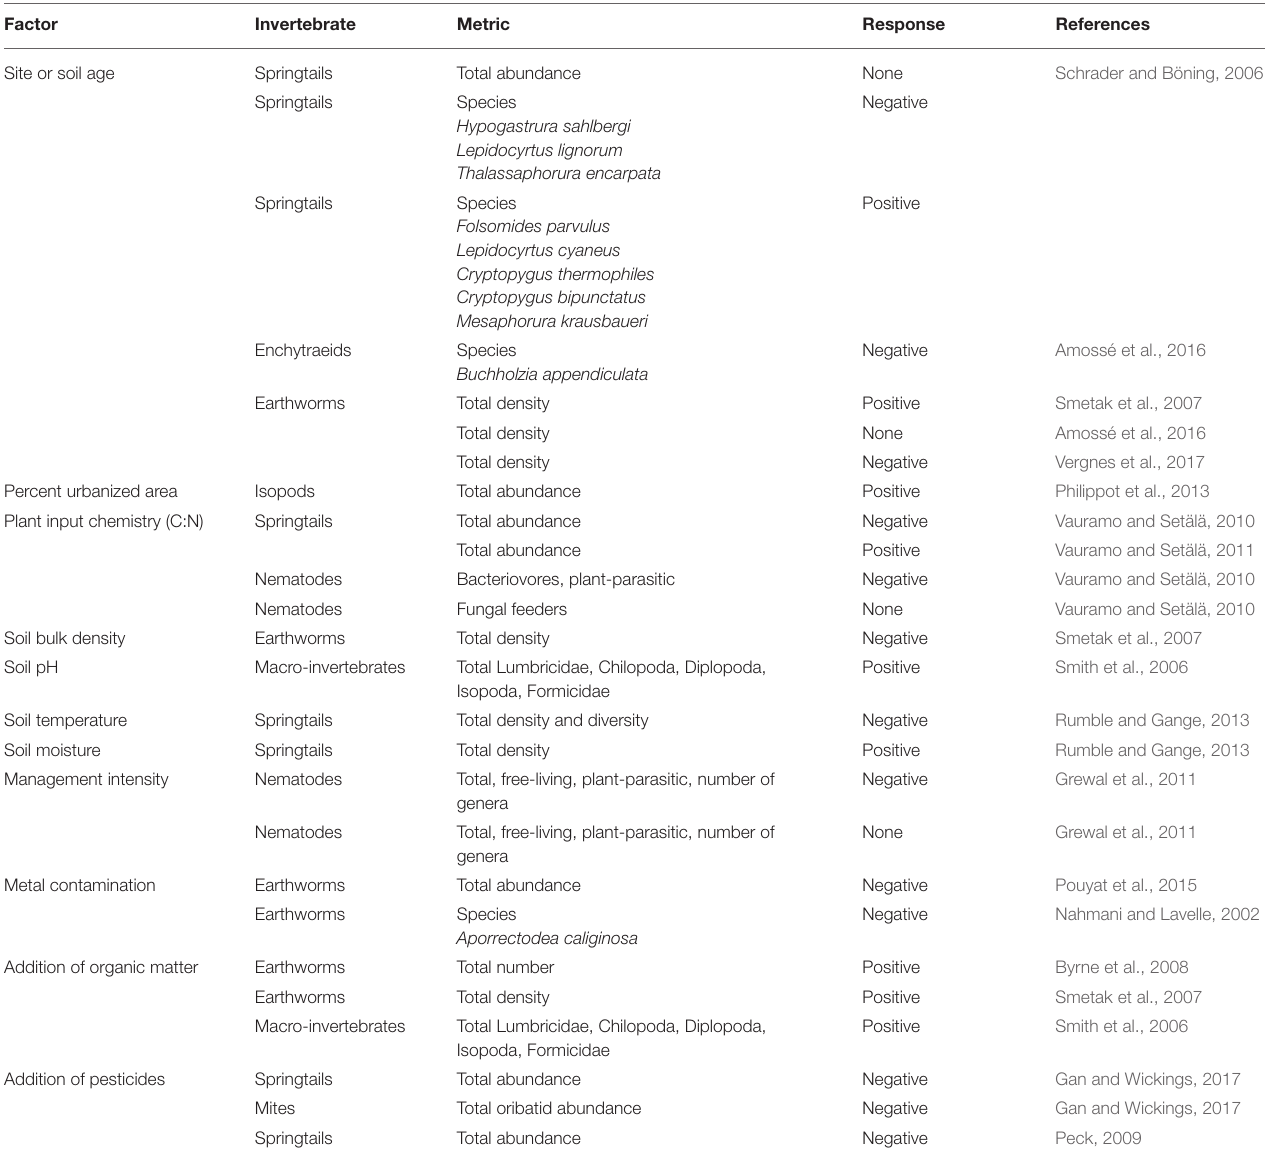
TABLE 1 | Select factors affecting invertebrates within urban soils; the response of the invertebrate community is either to an increase in the factor or to the addition of the